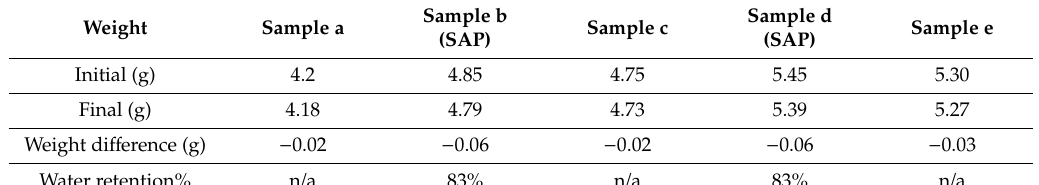
Table 2. Summary of the weights of samples.